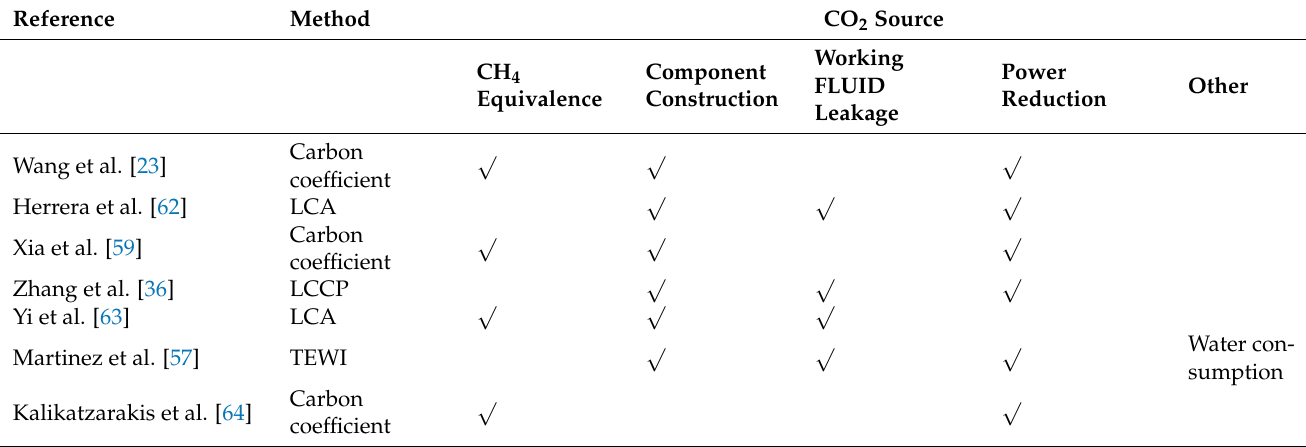
Table 2. Typical references involving carbon dioxide